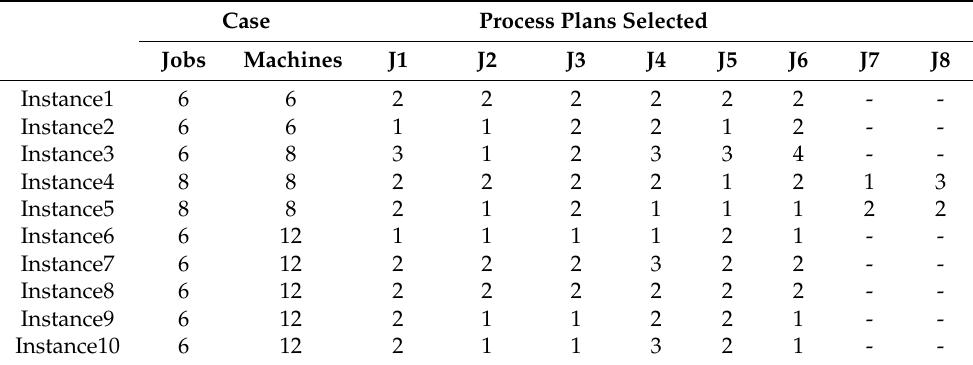
Table 8. Optimal process plans selected for each job for all practical instances